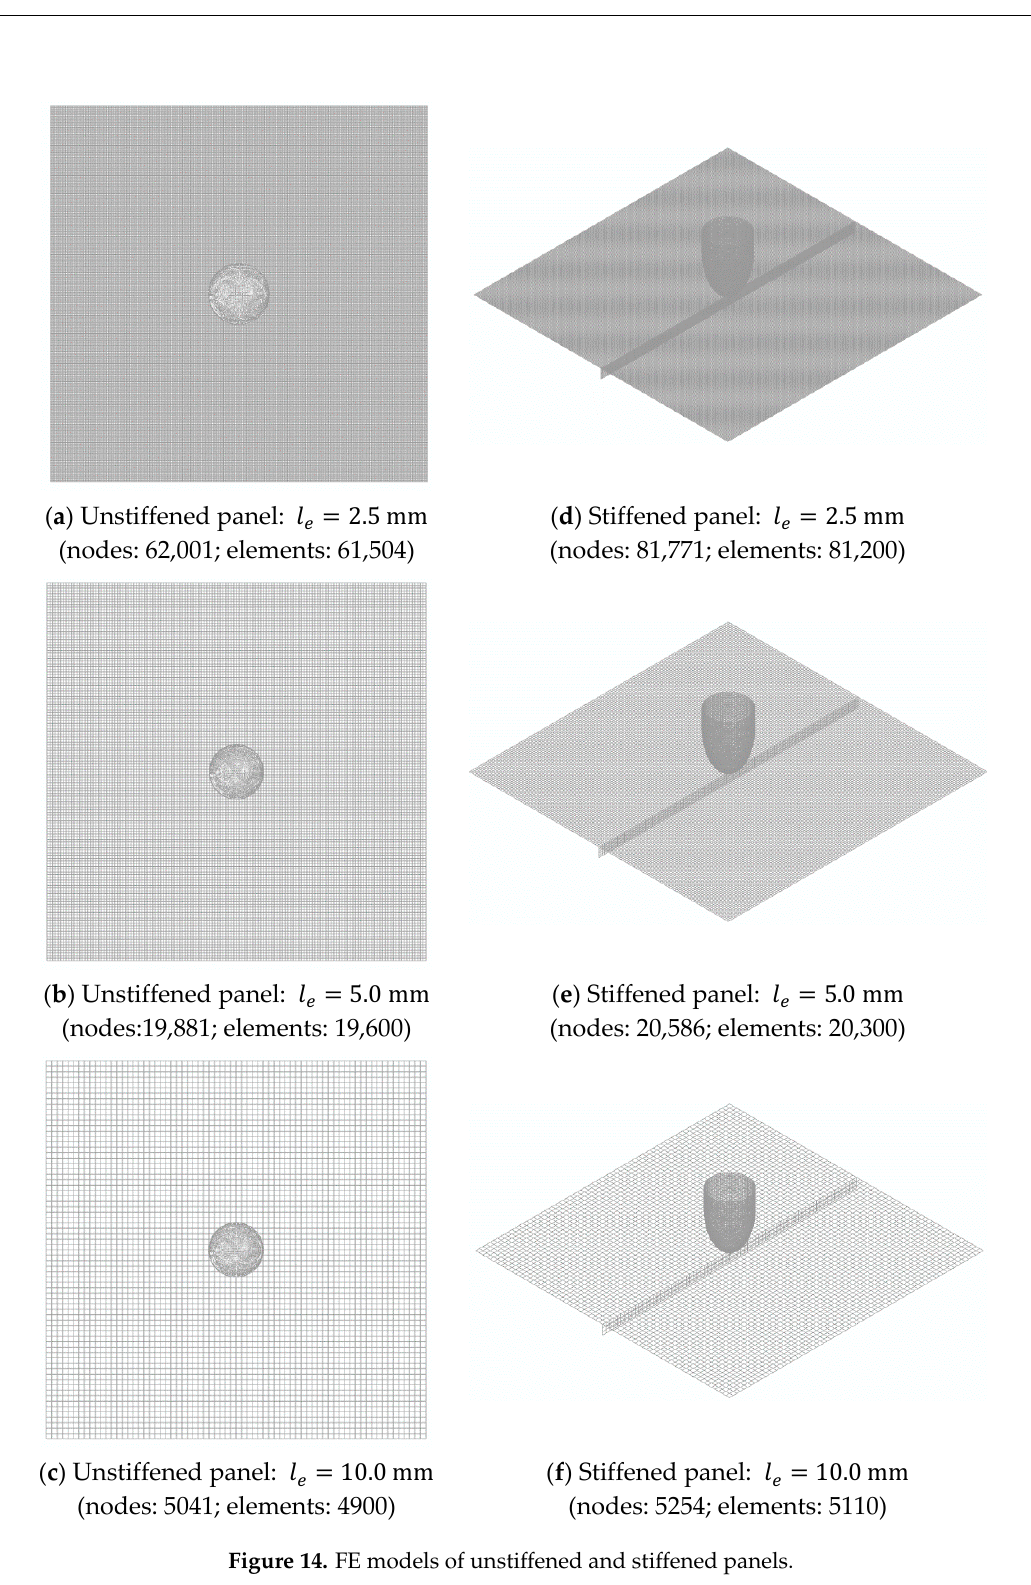
Figure 14. FE models of unstiffened and stiffened panels.